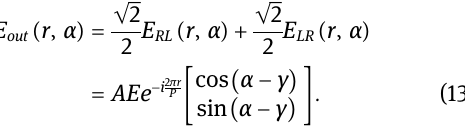
2.5 mm with a step of 0.1 mm along the y direction, and from